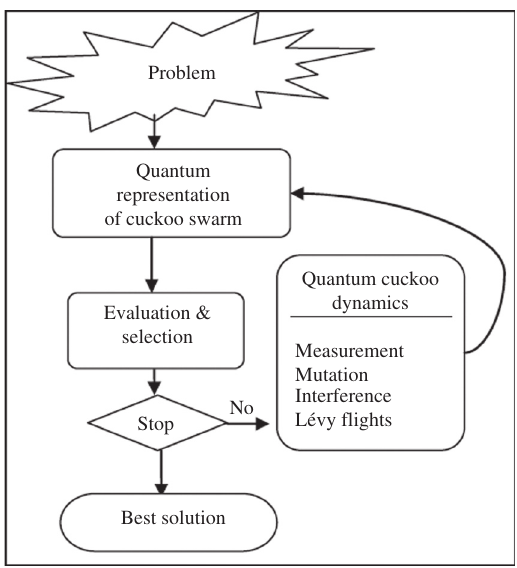
Figure 4. Architecture of Refinement